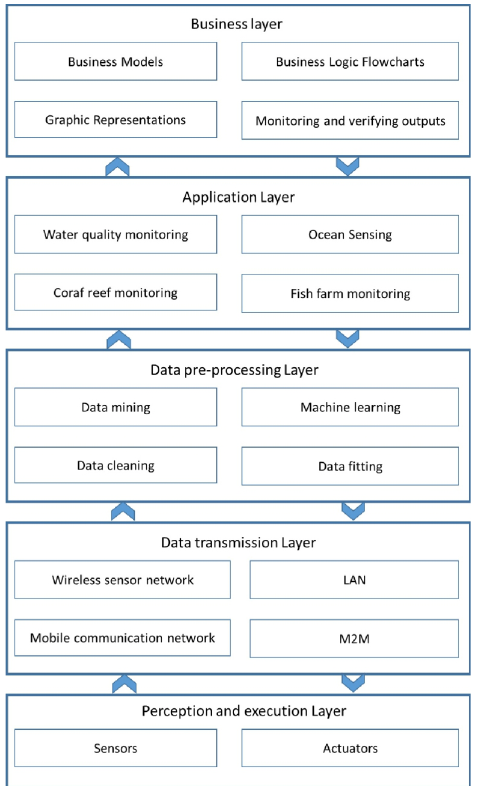
Figure 4 . Advanced IoT model for environment monitoring that can be reduced and adapted to the special case of oasis